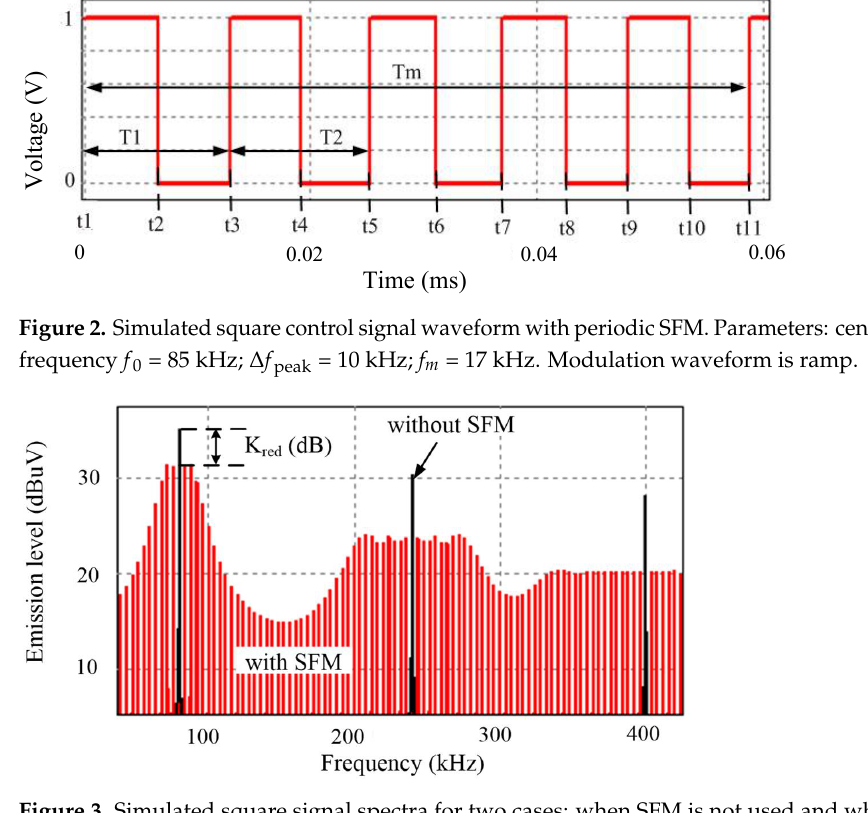
Figure 3. Simulated square signal spectra for two cases: when SFM is not used and when it is used.